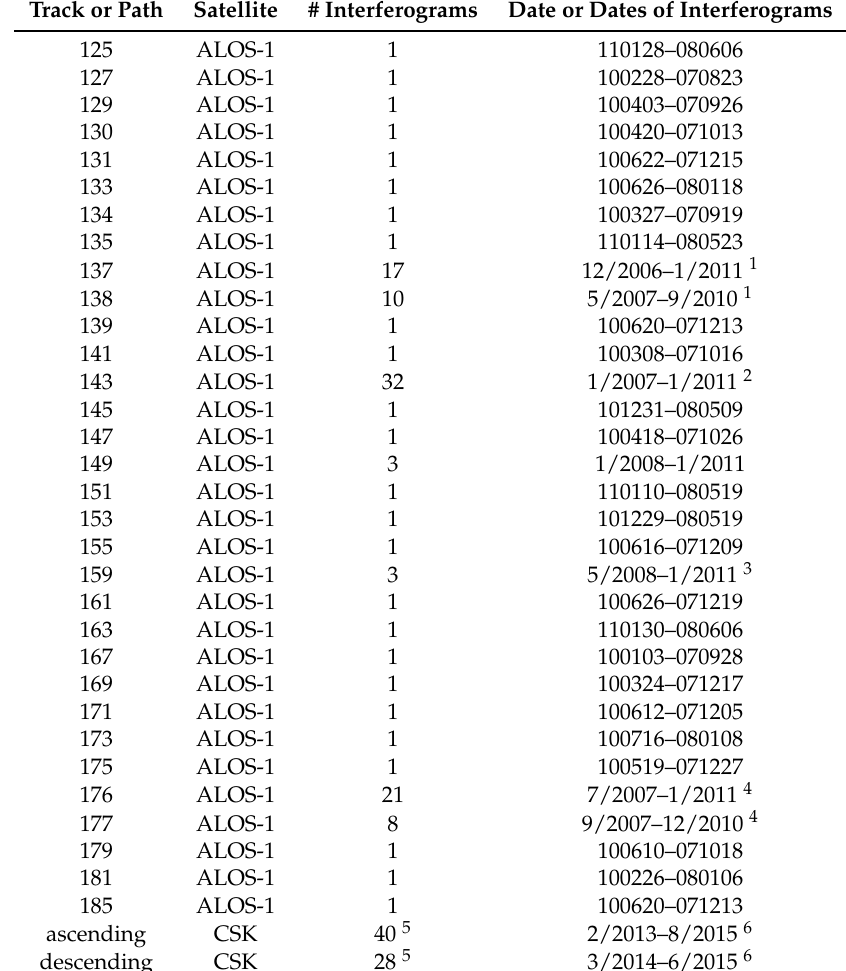
Table 2. Paths and dates (format: YYMMDD, except where multiple interferograms are used, when it is M/YYYY) of InSAR data (Figure 2) used in the eastern USA. 1 Time series of interferograms over a salt mine in western NY (Figure S7; [28]). 2 Multiple interferograms analyzed over coal mines in PA and WV (Figure S8). 3 Multiple interferograms created over coal mines in Alabama (Figure S11). 4 Multiple interferograms created over an area of known wastewater injection in Oklahoma (Figure 15). 5 This is the number of synthetic-aperture radar (SAR) acquisitions, there were more interferograms used in the time series. 6 Time series of interferograms over Alexandria, VA (Figure